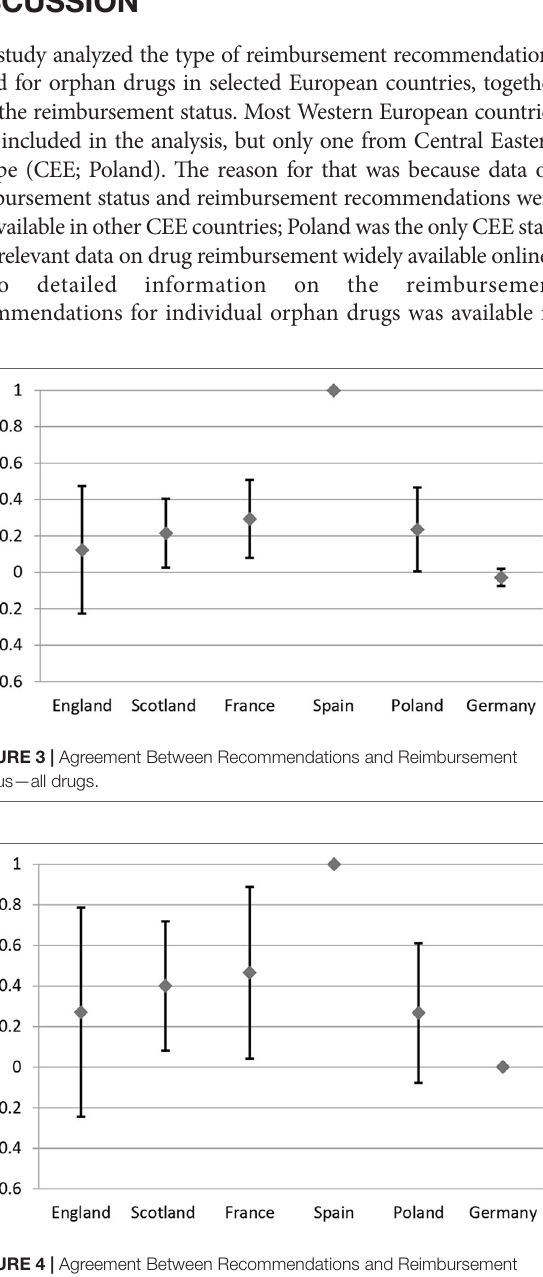
Frontiers in Pharmacology |